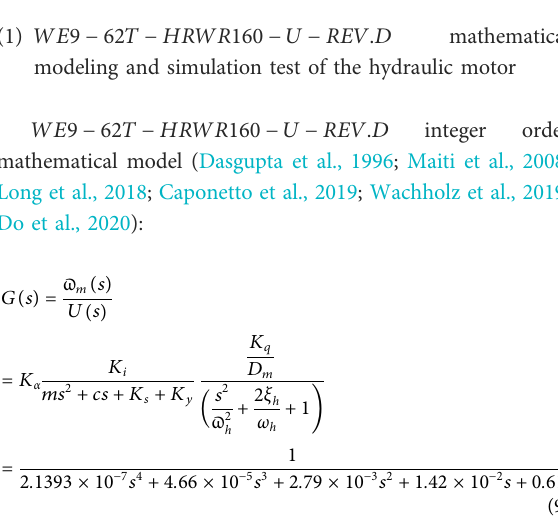
FIGURE 12 Flow chart of the intelligent optimization algorithm for